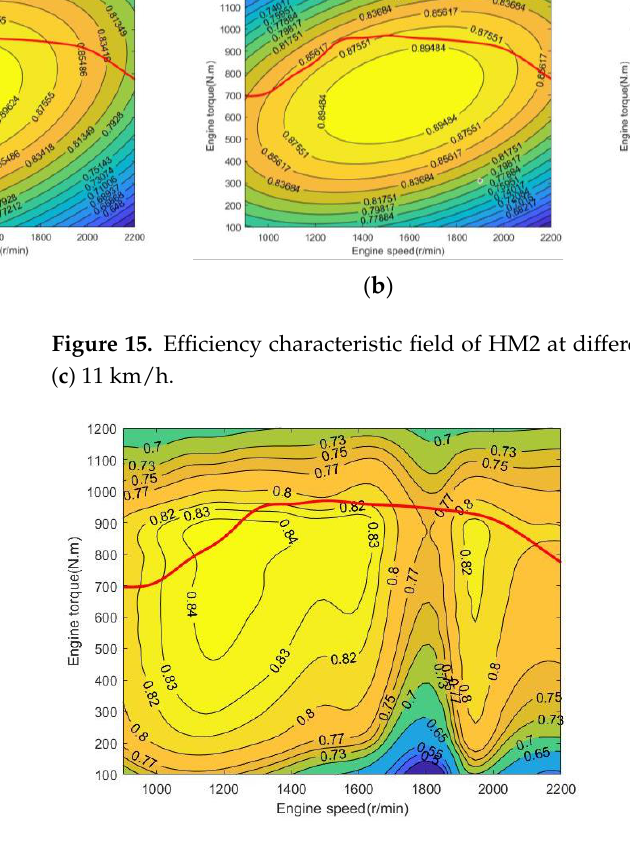
Figure 16. The characteristic efficiency field of HMCVT at the shift point (7.5 km/h) from HM1 to